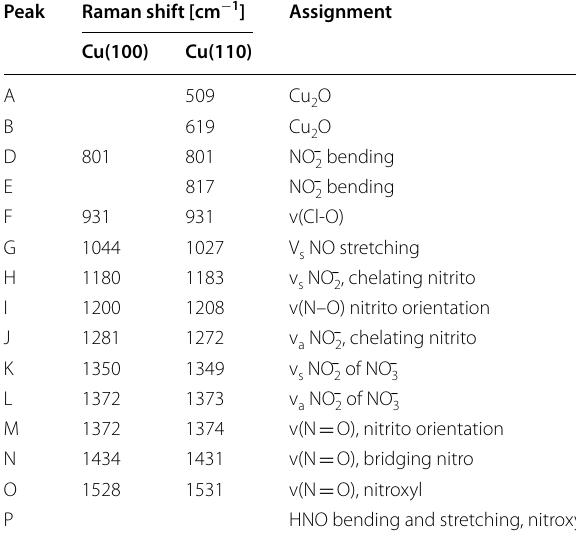
Table 3 Raman peak assignment for the NO and Cu(110) surfaces observed using the SHINERS technique [50]